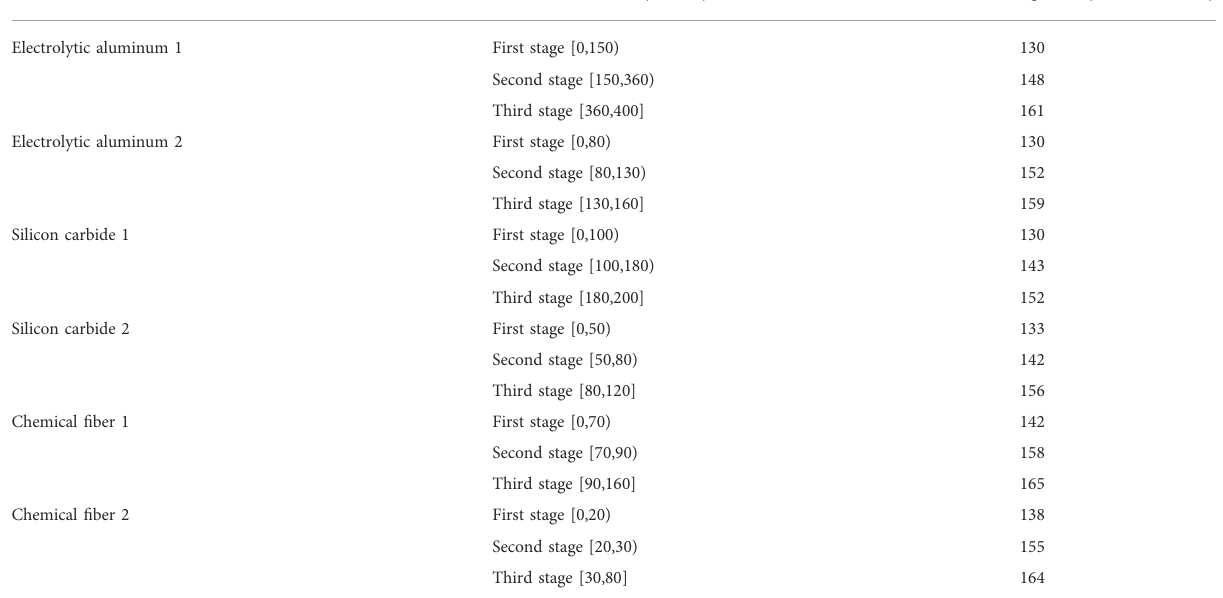
TABLE 2 First round declaration results of controllable load